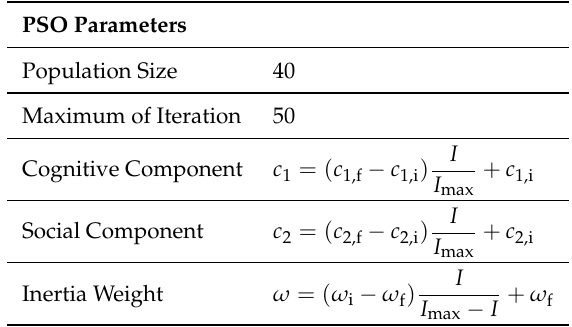
Table 1. The value of effective parameter for PSO algorithm.